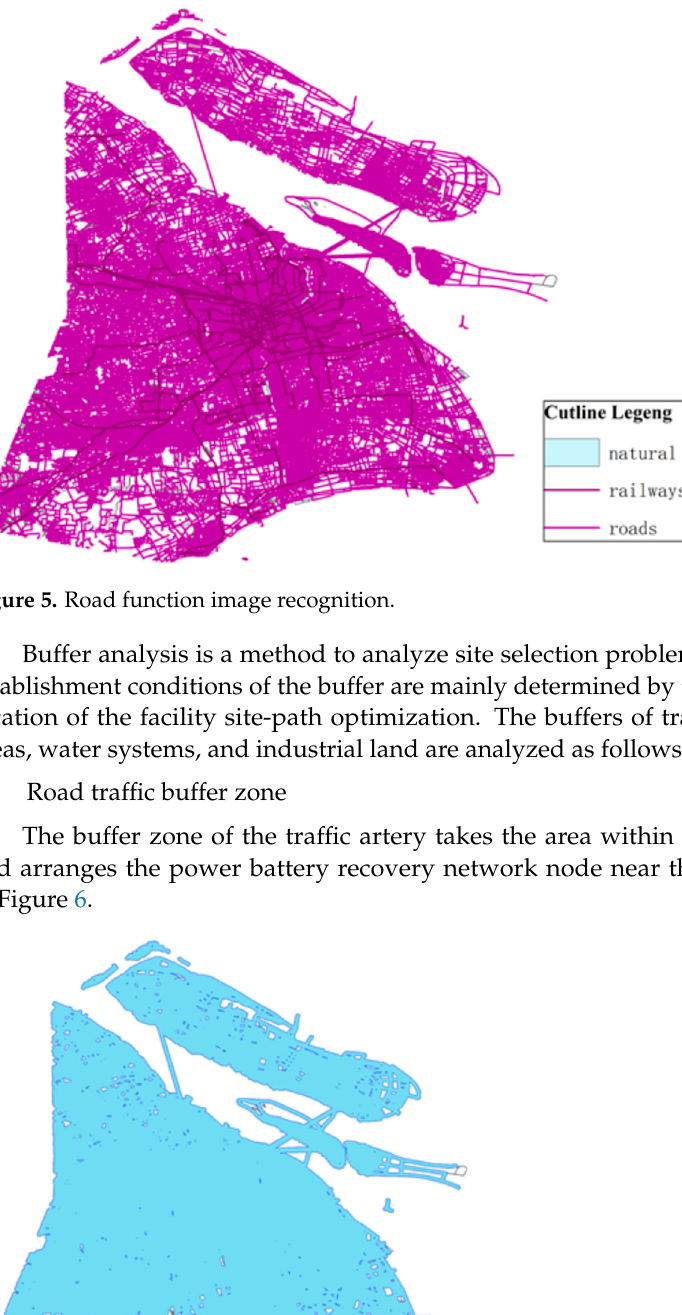
Figure 4. Region function image recognition.